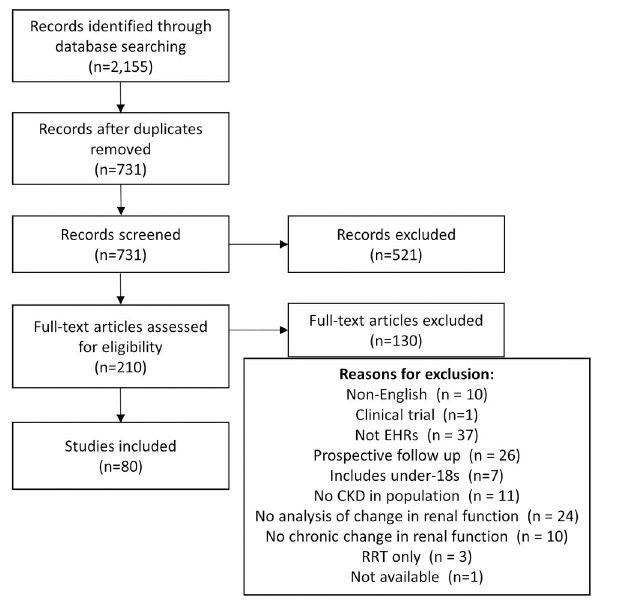
Fig 1. Flow chart of study